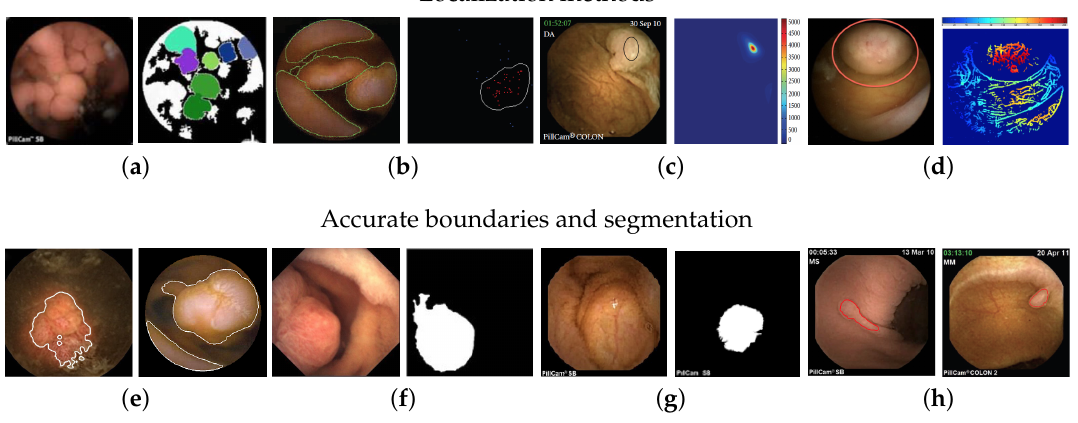
Figure 4. Example polyps localization and segmentations. ( top row): localization methods, ( a ) Log–Gabor filter [34]; ( b ) K-means, curvature [37]; ( c ) protrusion measure [40]; ( d ) vascularization [59]; ( bottom row):